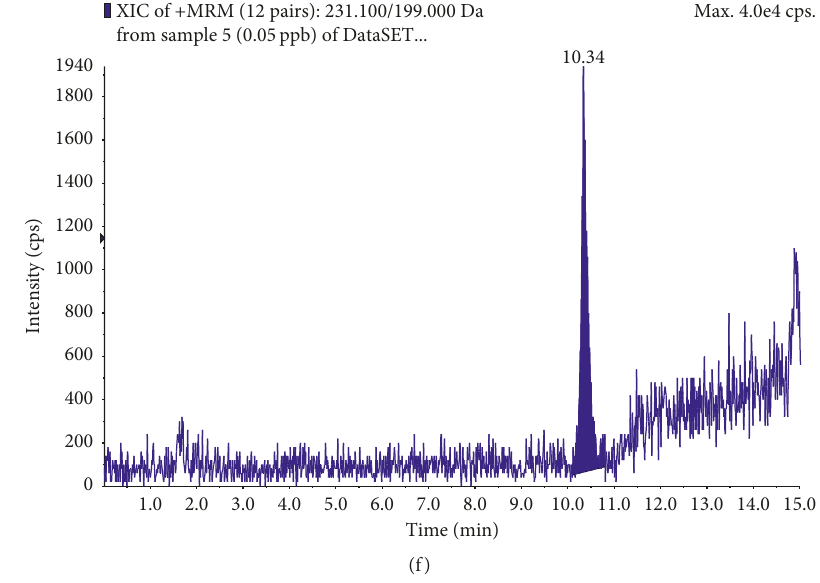
Figure 2: LC-ESI-MS/MS chromatograms in a positive-ion mode of (a) QCA (175.3 > 129.2), (b) MQCA (189.1 > 145.0), (c) DOLQ (232.2 > 143.2), (d) QCA-glycine (232.1 > 131.1), (e) MQCA-glycine (246.3 > 143.2), and (f) DCBX (231.1 > 199.0) fortified in the liver of swine. Table 2: LC-MRM parameters of MQCA, QCA, DOLQ, DCBX, MQCA-glycine, and QCA-glycine.